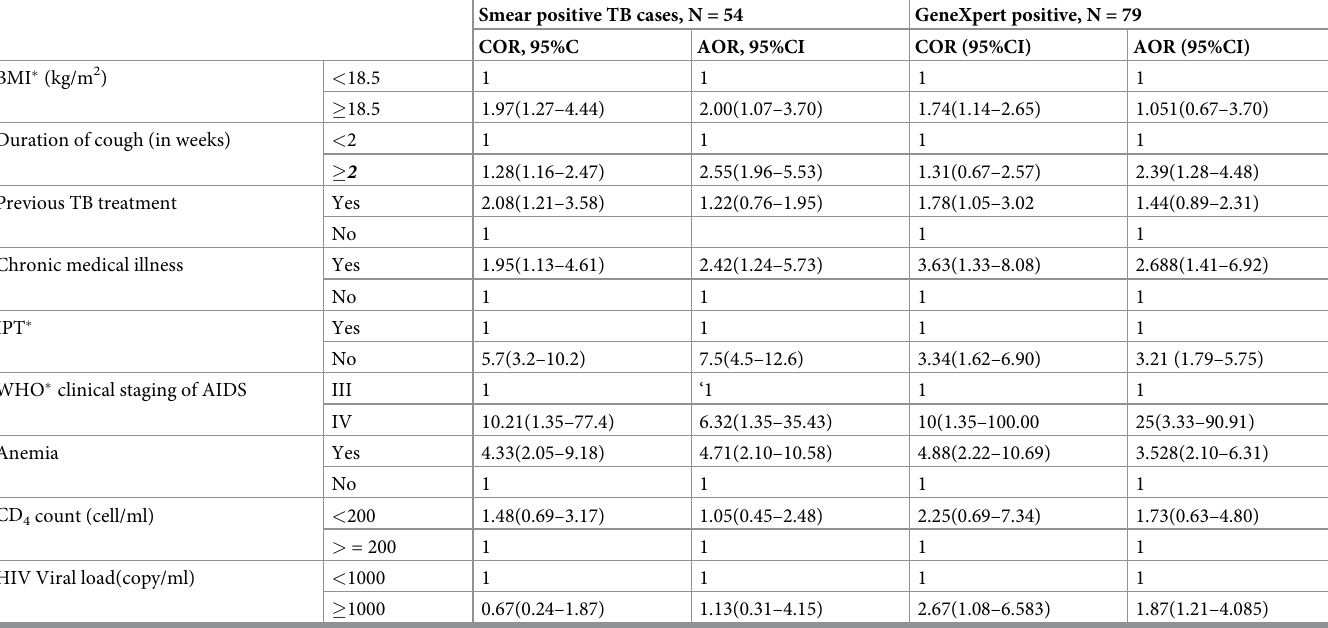
Table 4. Univariate and multivariate logistic regression assessing factors associated with the result of GeneXpert and smear AFB, Asella Teaching and Referral Hos- pital